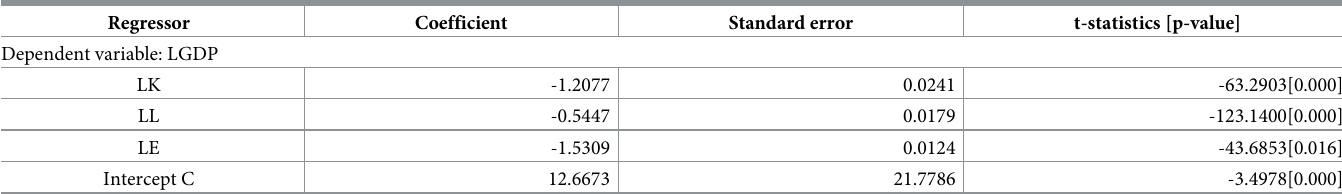
Table 4. Estimated long-run coefficients based on ARDL (4,4,4,0).